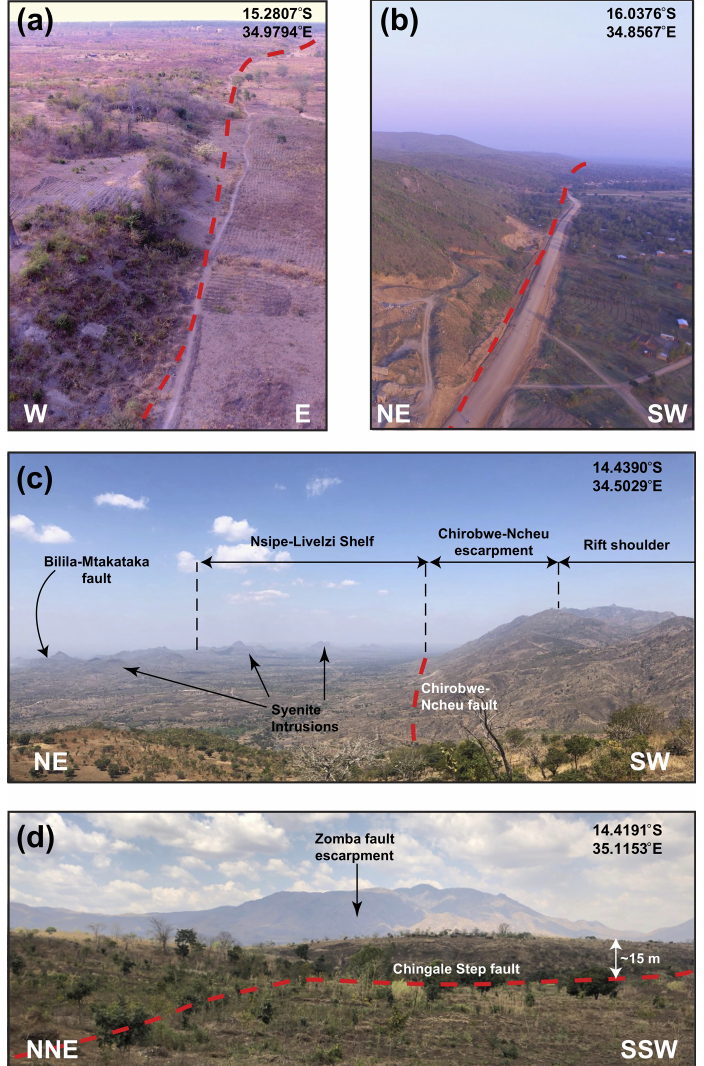
Figure 3. Field examples of border and intra-basin faults in southern Malawi. Unmanned aerial vehicle (UAV) images of scarps (dashed red line) along the (a) intra-basin Mlungusi Fault in the Zomba Graben as well as (b) the Thyolo Fault – the border fault for the Lower Shire Basin. (c) View across the western edge of the Makanjira Graben showing the Chirobwe–Ncheu and Bilila–Mtakataka faults as well as Proterozoic syenite intrusions (Walshaw, 1965). (d) Minor step in the scarp along the intra-basin Chingale Step fault, with the escarpment of the Zomba border fault